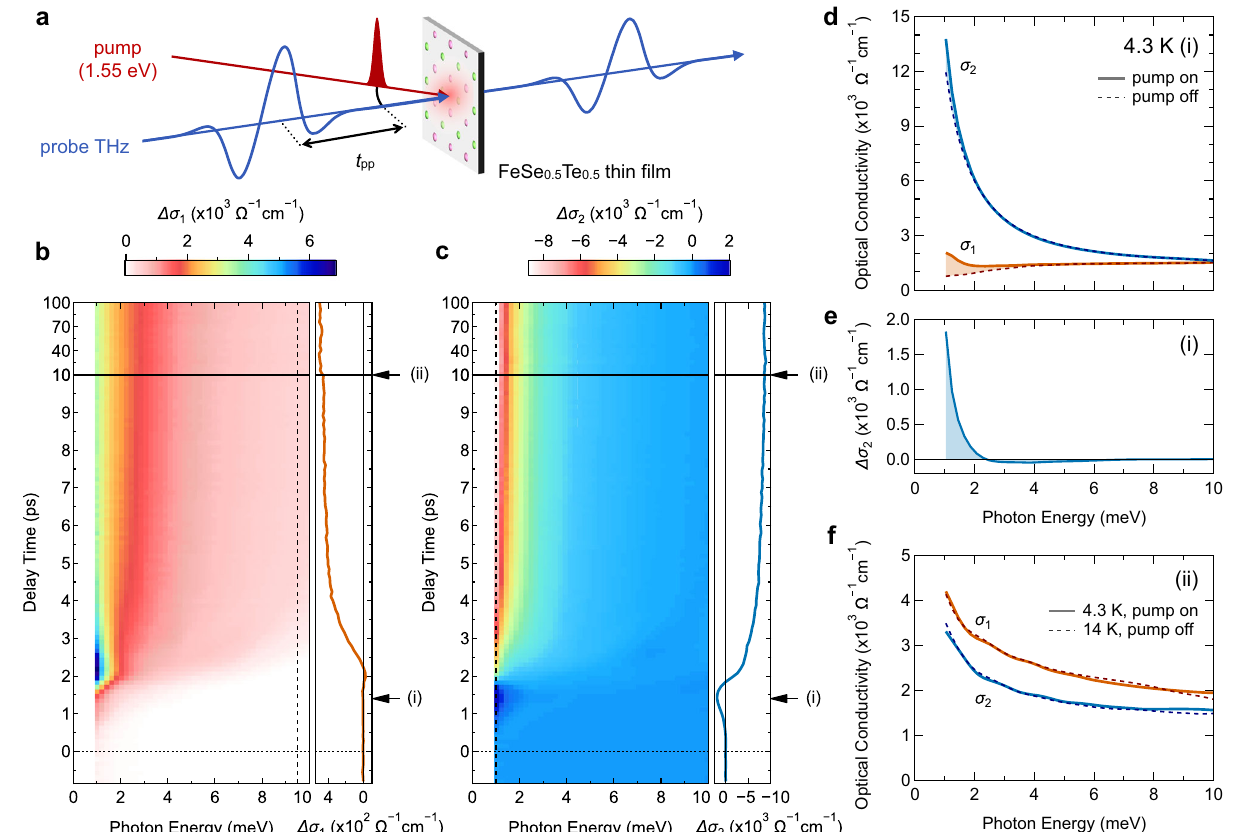
(cid:1) (cid:3) (cid:1) (cid:3) ¼ ~ σ ω ; t (cid:2) ~ σ eq ω ð Þ ( b : pp (cid:1) (cid:3) are shown as functions of t pp in their right panels. Black arrows (cid:1) (cid:3) , at t pp = 1.4 ps (red: real part; and blue: (cid:1) (cid:3) at t pp = 10 ps (red: real part; and blue: